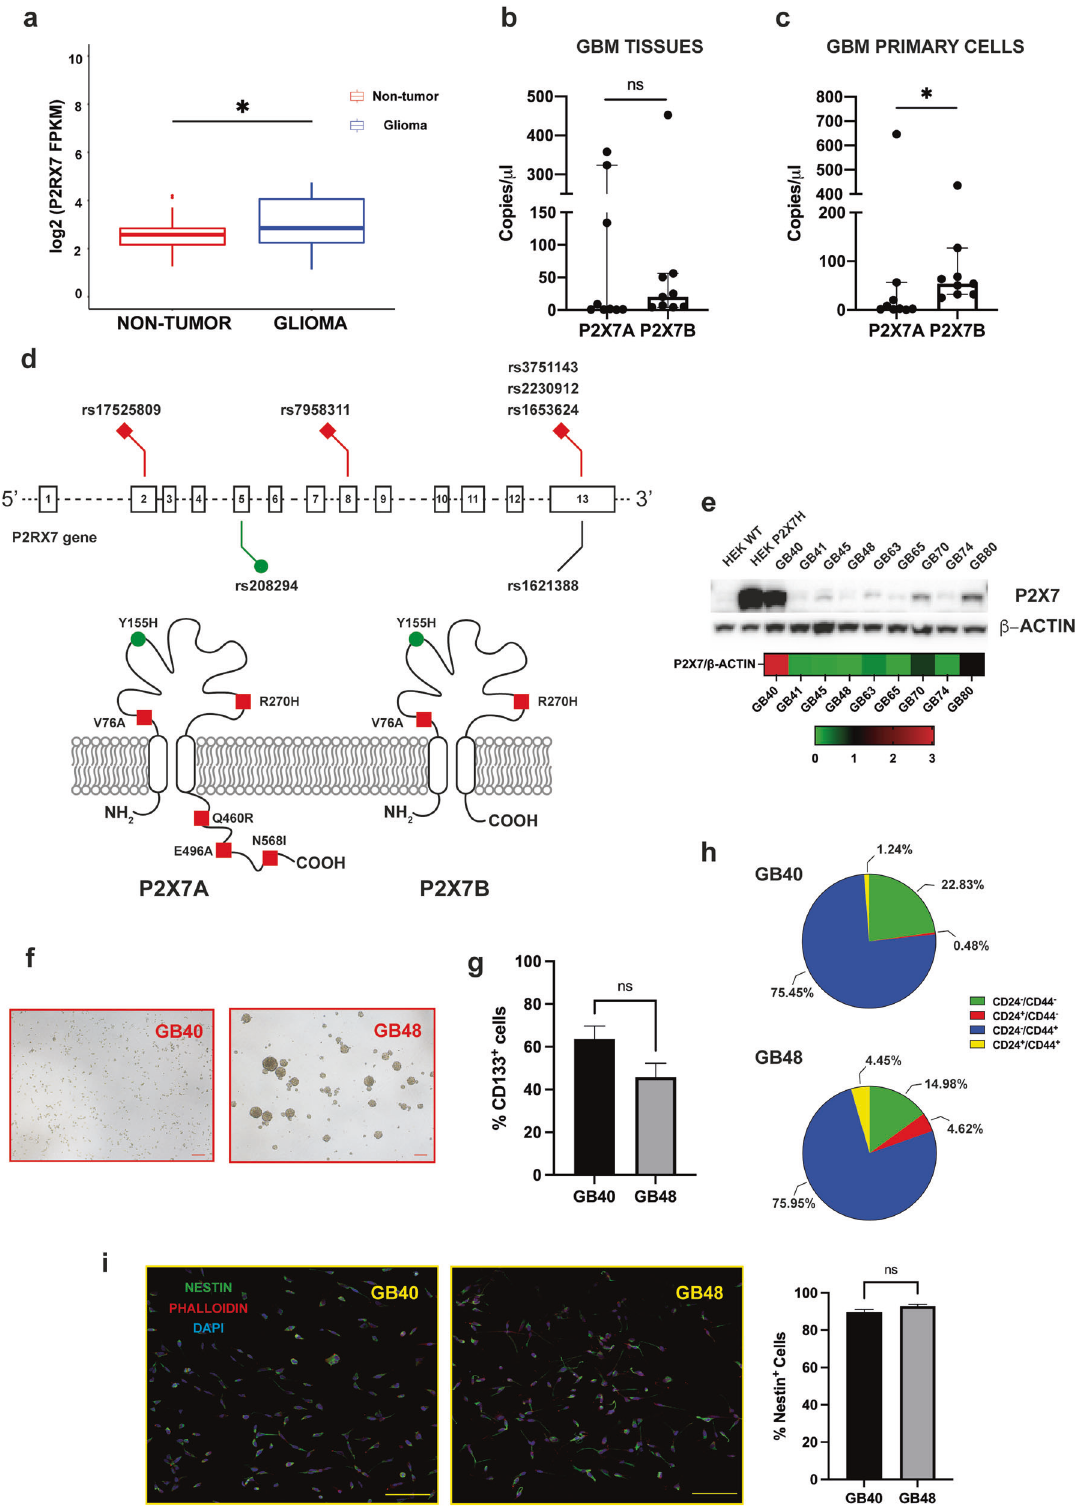
Exon-sequencing analysis Genomic DNA from eight GBM primary cell lines was extracted using the QIAamp DNA Mini kit (QIAGEN) according to the manufacturer ’ s instructions. DNA for each sample was quanti fi ed by means of Qubit 2.0 Fluorometer (Invitrogen), and subjected to quality control using the Agilent 2100 Bioanalyzer (Agilent Technologies). Samples were sequenced